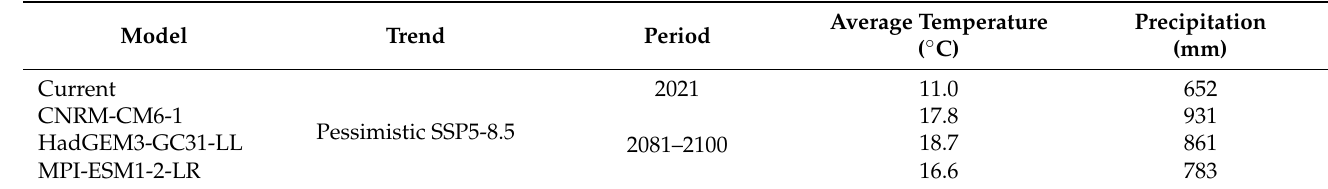
Table 3. Average projections of climate change